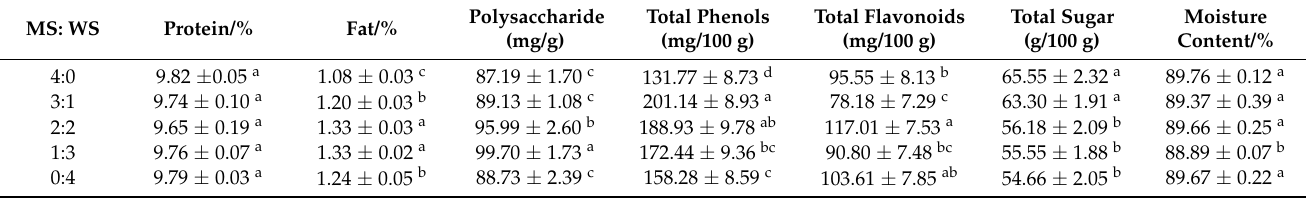
Table 2. Nutritional quality of basidiocarp of A. auricula cultivated with different walnut supplemen- tal levels.